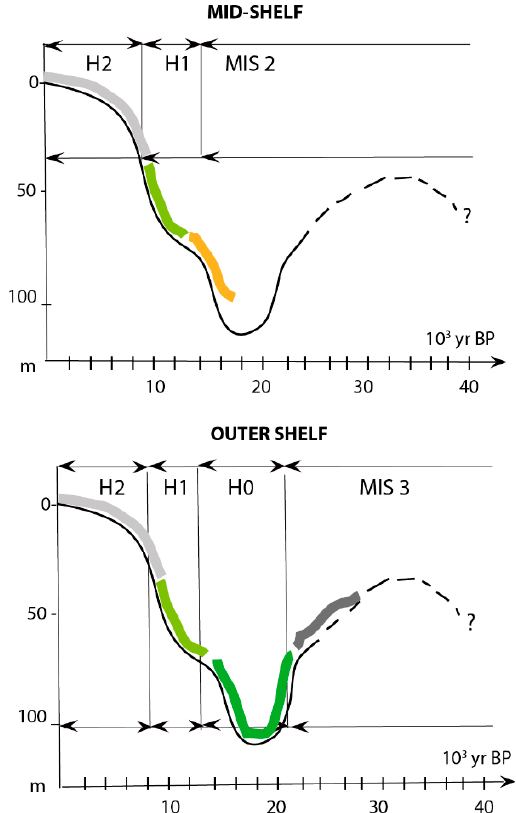
Figure 7. The main sedimentary sequences on the mid-shelf and the outer shelf of the Congolese plateau, according to the glacio-eustatic movement of the shoreline. H2: late Holocene (muddy